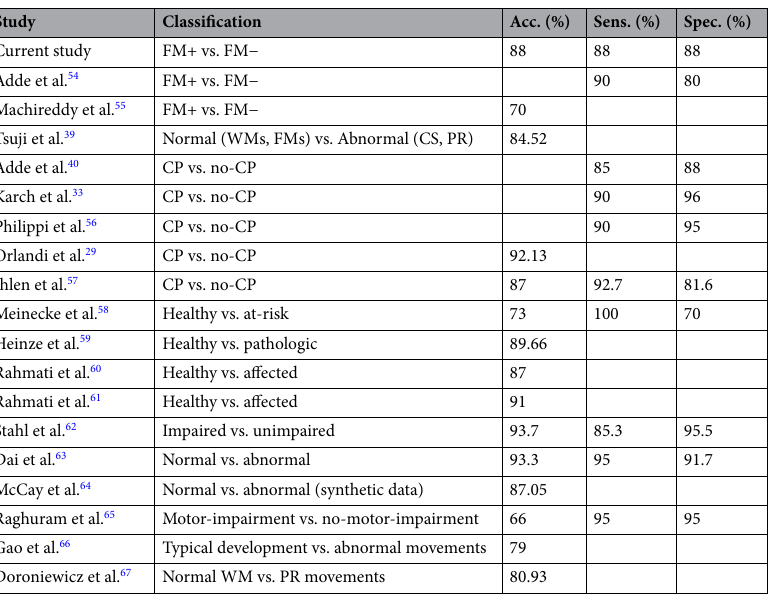
Table 5. Comparison of our approach to the state of the art methods from other studies. The upper part of the table presents studies focusing on fidgety